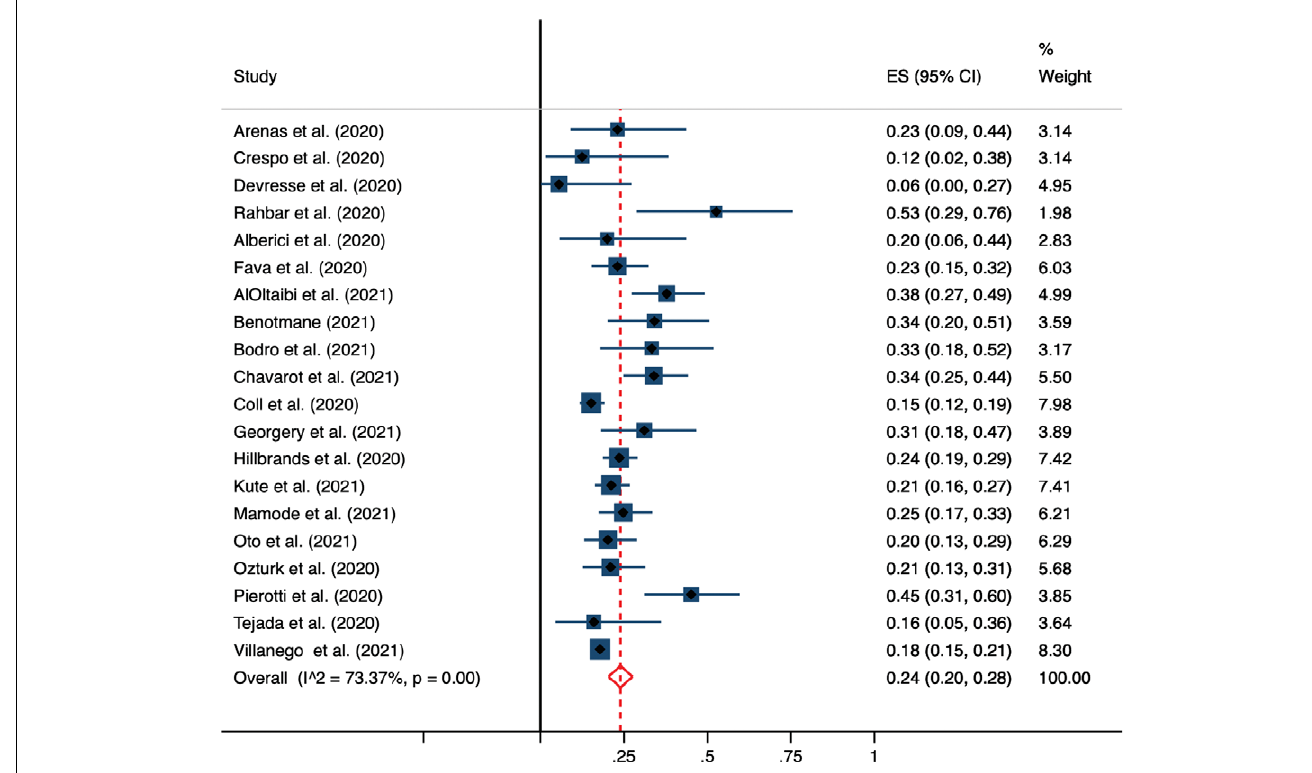
Figure 4. Pooled estimate on ICU admission rate of kidney transplant recipients with COVID-19